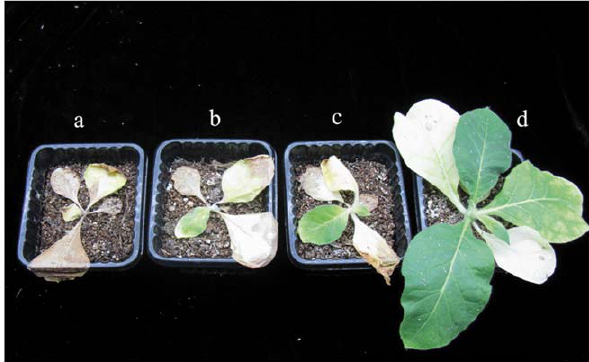
Figure 6. The transgenic plants were sprayed with glyphosate at a dose of 5 mM. Injury was observed visually 2 weeks after the application. (a) nontransformed plants; (b) transgenic tobacco line Ec3; (c) transgenic tobacco line mRa1; and (d) transgenic tobacco line Ra11. For (B) and (C), the same results were obtained in three independent experiments and are represented by the effects shown